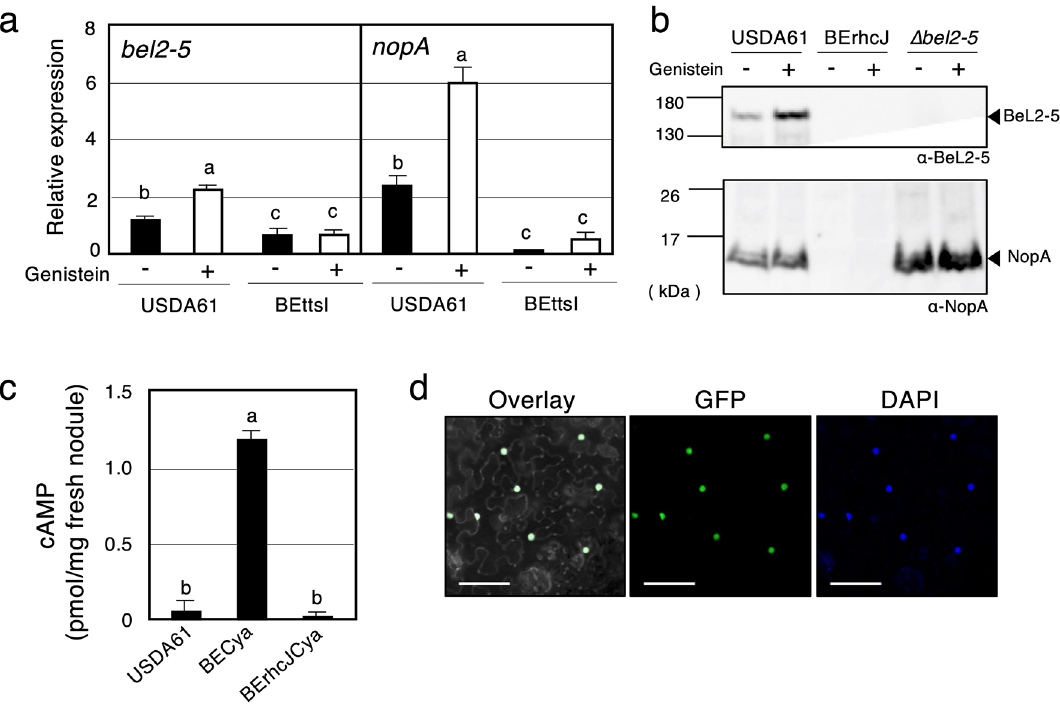
Figure 3. Expression, secretion, translocation and localization of the B. elkanii type III effector Bel2-5. ( a) RT-qPCR analysis of bel2-5 and nopA expressions in wild-type and ttsI mutant (BEttsI) of B. elkanii USDA61. Total RNAs were isolated from cultures in the absence (−) or presence (+) of the genistein (10 µM) after 48 h induction. The expression level of each gene was normalized by the ATP synthase ( atpD ) gene. Values represent mean ± SD ( n = 3). ( b ) Secretion of Bel2-5 and NopA in the culture supernatant of B. elkanii strains. Secreted proteins from culture supernatants were subjected to immunoblot analysis with the anti-Bel2-5 (α-Bel2-5) or anti-NopA (α-NopA) antibodies. Molecular masses (kDa) of the marker are shown on the left. ( c ) Translocation of Bel2-5 into soybean nodules. cAMP levels measured from G. max cv. Enrei nodules harvested at 18 dpi. Plants were inoculated with B. elkanii USDA61 wild-type, BECya and BErhcJCya. The USDA61 wild-type contained no cya fusion. Values represent mean ± SD from duplicates measurements. ( d ) Bel2-5 is targeted to the plant nuclei. Bel2-5 protein fused with eGFP was transiently expressed in N. benthamina leaves by Agrobacterium infiltration and visualized 48 h after by confocal microscopy to determine the subcellular localization. From left to right: an overlay of GFP and DAPI fluorescence spectrums, and the GFP and DAPI fluorescence spectrum, respectively. Staining with DAPI was used to visualize nuclei. On the overlay panel, the DAPI fluorescence was displayed in gray and the contrast and brightness were enhanced in order to be able to visualize the contour of the cells. Scale bars: 100 µm. Means followed by different letters are significantly different at the 0.05 level by Tukey’s method ( a , c